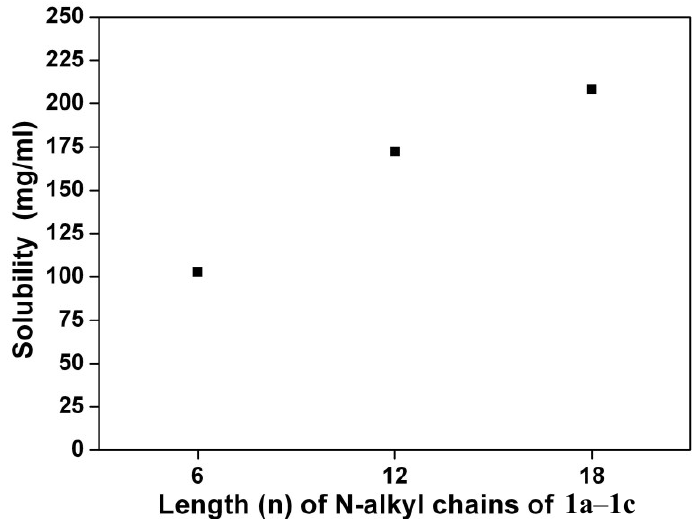
Figure 1. Solubility of 1a – 1c in dichloromethane (25